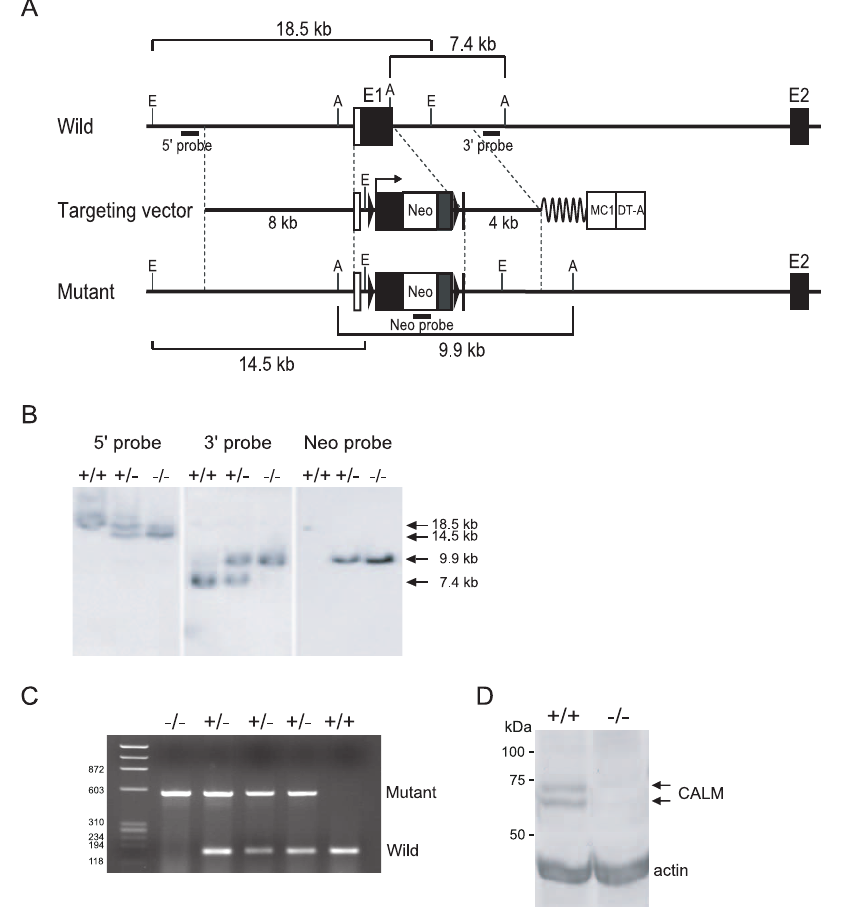
Figure 1. Targeted disruption of the CALM gene. (A) Schematic of the targeting strategy used for disruption of the first coding exon of CALM . (B) Southern hybridization analysis of DNA isolated from targeted mouse embryos. From left to right: 5 9 probe, 3 9 probe and neo probe, as shown in A. (C) Genomic PCR analysis of DNA isolated from mouse tail. The genotypes are indicated above each lane. (D) Immunoblot analysis of stable MEF cell lines from wild-type ( + / + ) and CALM -deficient ( 2 / 2 ) mouse embryos (E14.5). The expected molecular weights of CALM are 62 and 72 kDa (arrows).